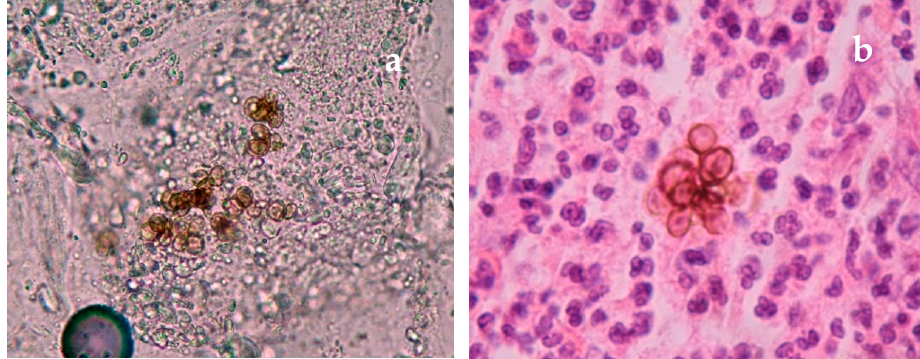
Figure 3. ( a ) Direct microscopy skin scales (15% KOH). Muriform cells typical of Chromoblastomycosis; ( b ) Skin biopsy. Muriform cells of chromoblastomycosis (HE) ×